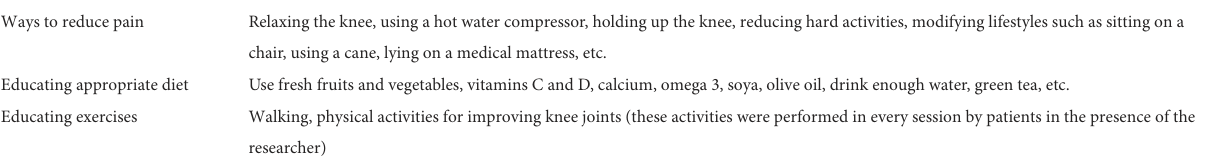
TABLE 1 Educational self-care program.